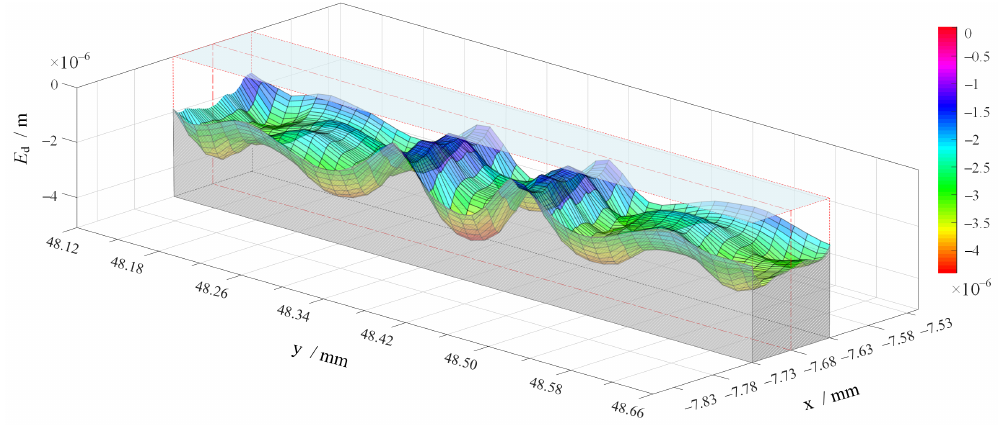
Figure 19. Erosion depth distribution after 1000h for oil of NAS